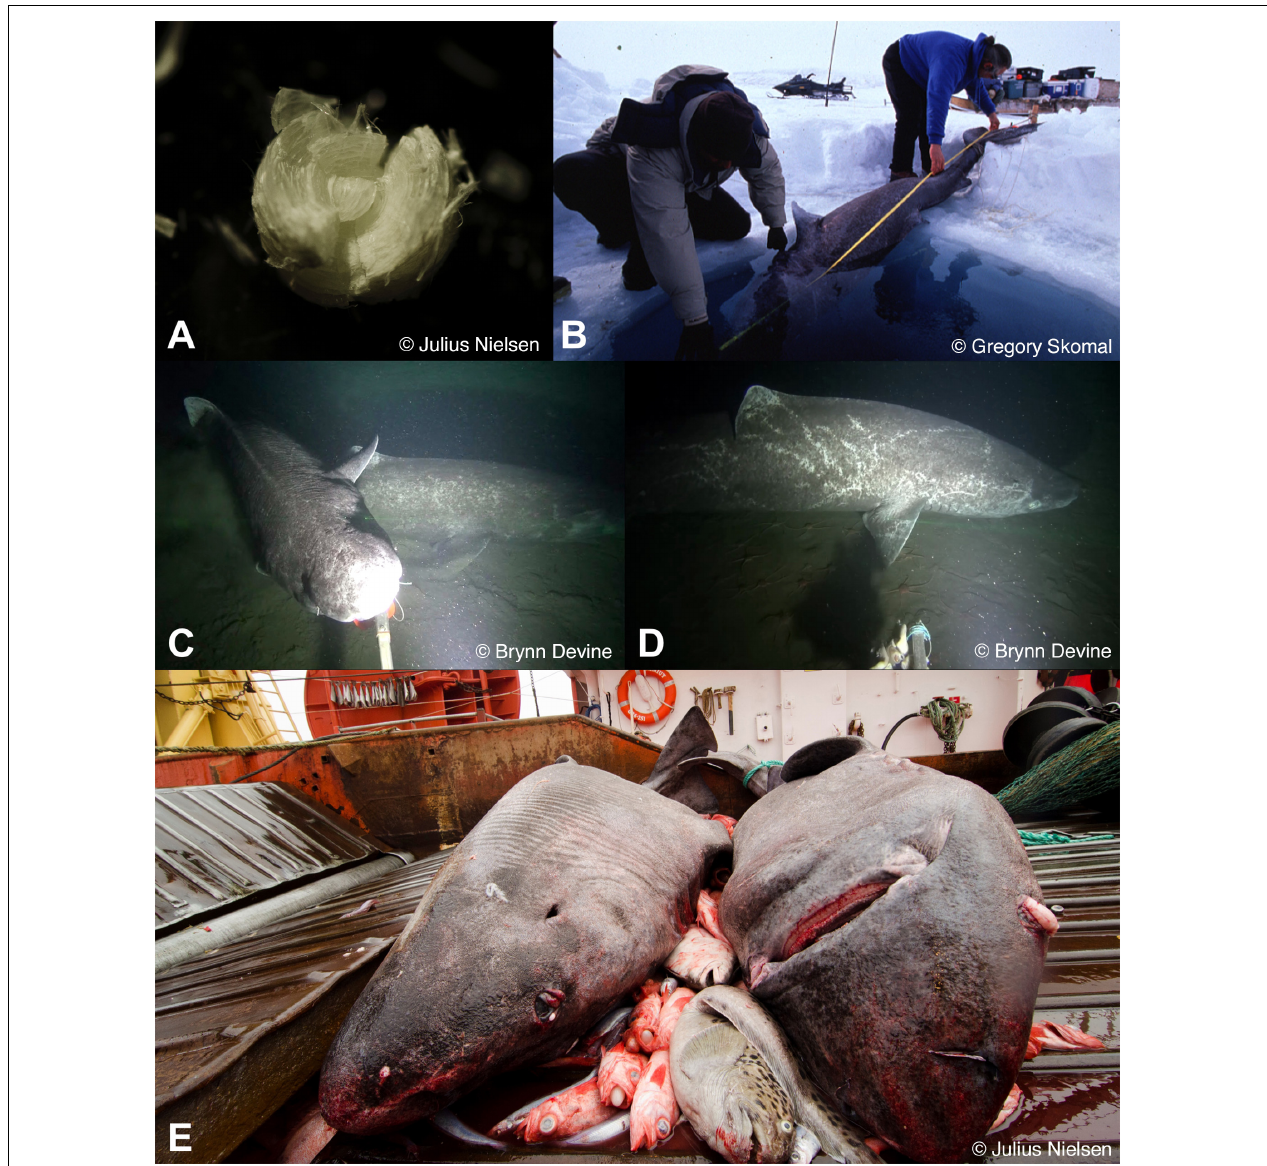
FIGURE 2 | Examples of Greenland shark demographics research. (A) Greenland shark eye lens for use in radiocarbon dating (photo Julius Nielsen, used with permission). (B) Measuring the length of a Greenland shark captured through ice (photo Gregory Skomal, used with permission). (C) Multiple Greenland sharks captured on BRUV footage (photo Brynn Devine, used with permission). (D) BRUV image showing scar patterns used for identification of individual Greenland sharks (photo Brynn Devine, used with permission). (E) Greenland sharks caught as bycatch in a fisheries trawl (photo Julius Nielsen, used with